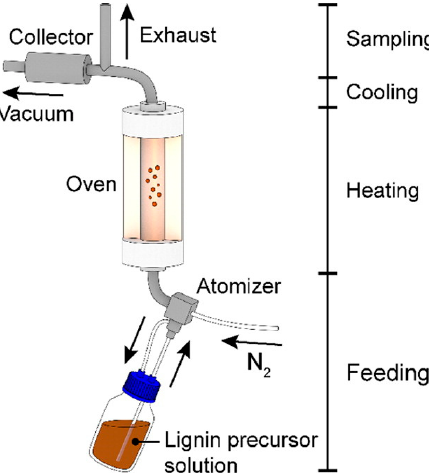
Figure 12. Schematic aerosol following reactor setup used for lignin particle synthesis. Reprinted with permission from Ago et al. [114]. Copyright 2016 American Chemical Society.